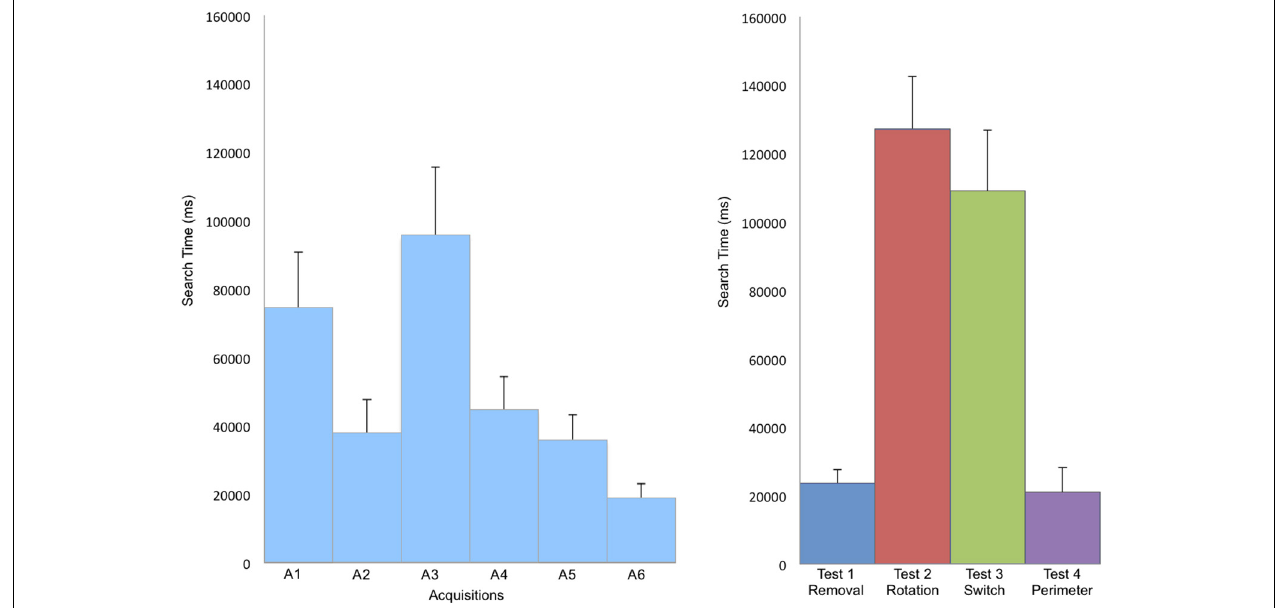
FIGURE 2 | Mean search time in ms to find the target during acquisition (A) and in the tests (B). Search time significantly decreases during the learning phase of the acquisition trials. Performances decreased